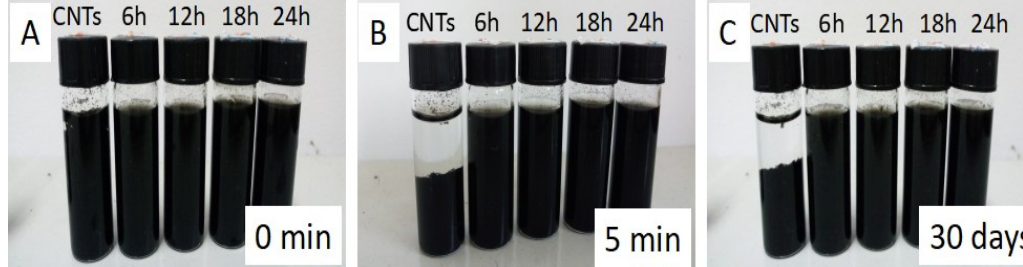
Figure 4. Image of the dispersion of pure CNTs and CNTs@pDA modified at different times (6, 12, 18, and 24 h). ( A ) Image of the dispersion of the samples at the initial time. ( B ) Image of the dispersion of the samples after 5 min settling time where the pure CNTs had subsided and CNTs@pDA maintained a dispersed state. ( C ) Image of the dispersion of the samples after 30 days settling time where the CNTs@pDA still maintained its dispersion.